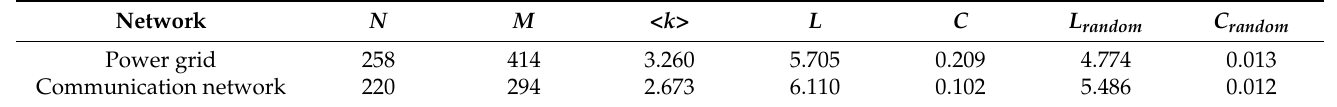
Table 1. The structure characteristic parameters of a complex network between the power grid and the communication network in the